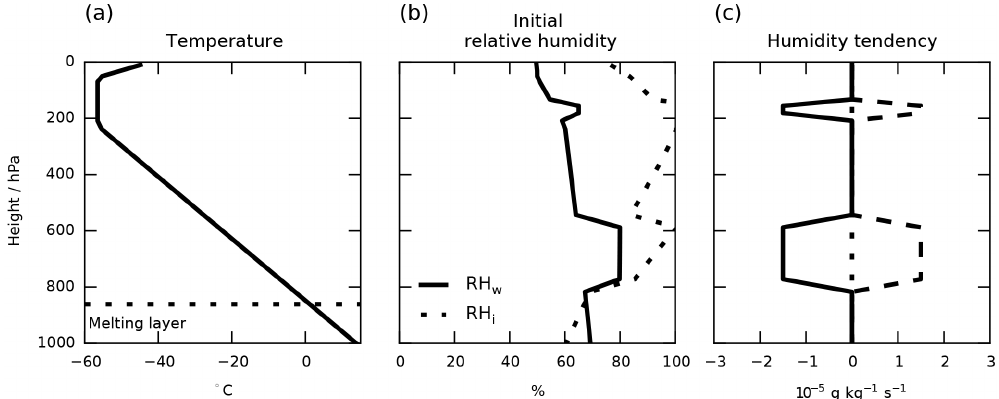
Figure 8. Vertical profiles of the single-column model initial conditions and forcing terms. (a) The temperature is initially set to the inter- national standard atmosphere temperature profile. (b) The humidity profile allows for cloudy regions in cirrus and mixed-phase regimes. (c) The humidity forcing terms that are applied to initiate cloud formation. Solid lines show the forcing during cloud formation, dotted lines show the stable phase without forcing, and the dashed lines show the forcing of cloud